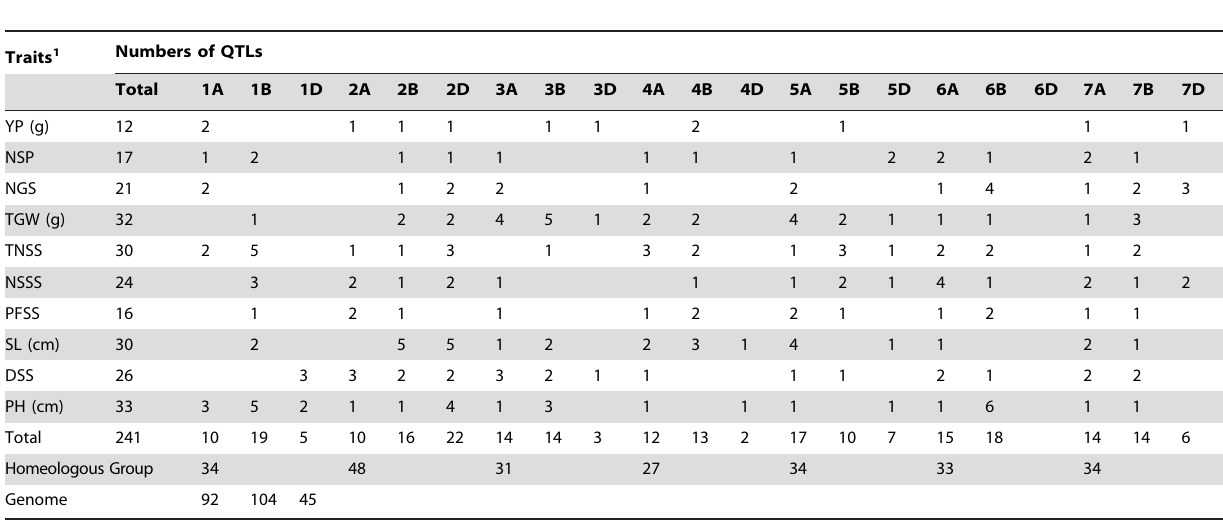
Table 5. Distributions of QTLs for yield associated traits in wheat DH lines across